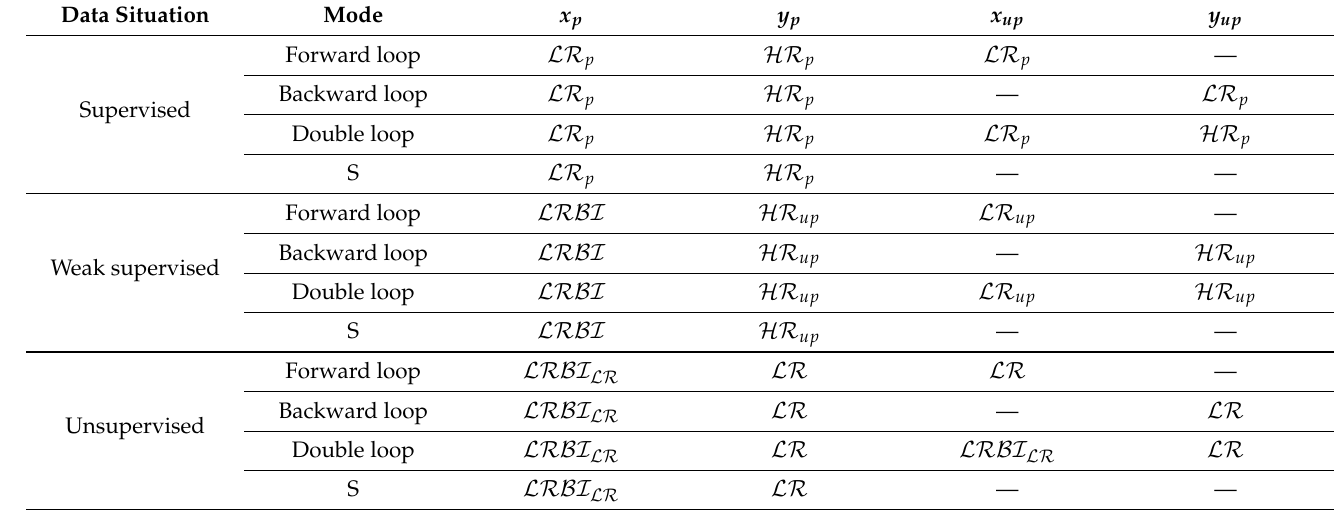
Table 3. The training data of different training modes at different data situation. (— means not used.)